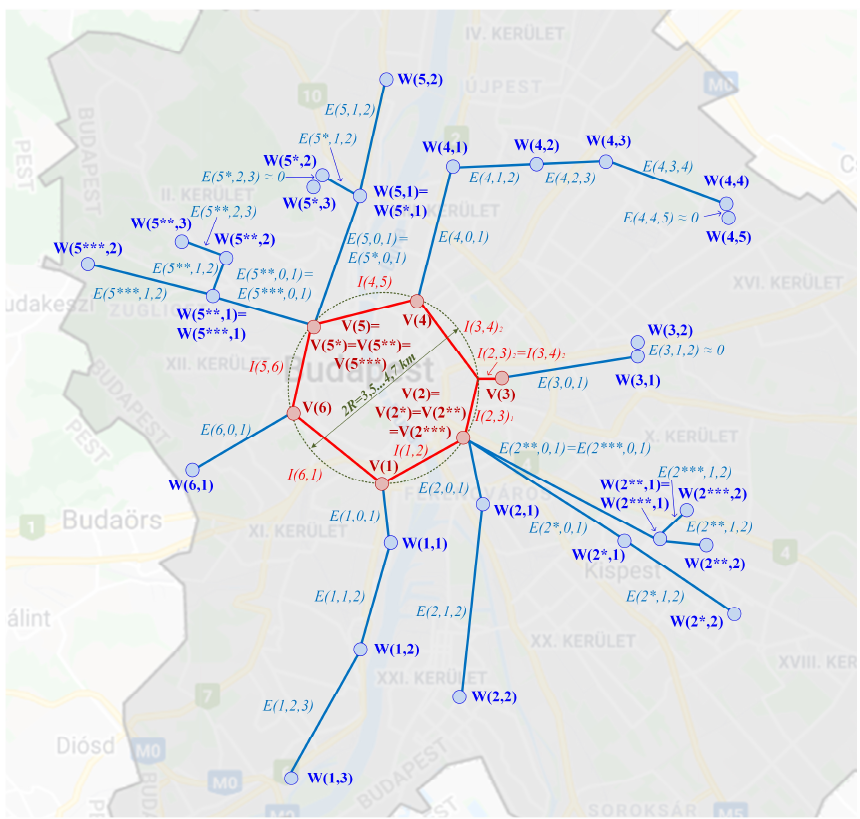
Figure 14. Geometrical model of the shopping malls in Budapest. For the examination of the geometrical model of the shopping malls in Budapest, all the main indicators were calculated (distances, goods amount, number of CSDLs) and were defined and described in the previous sections. The results can be seen in Table 2. Table 2. Main parameters of the geometrical model of the shopping malls in Budapest.